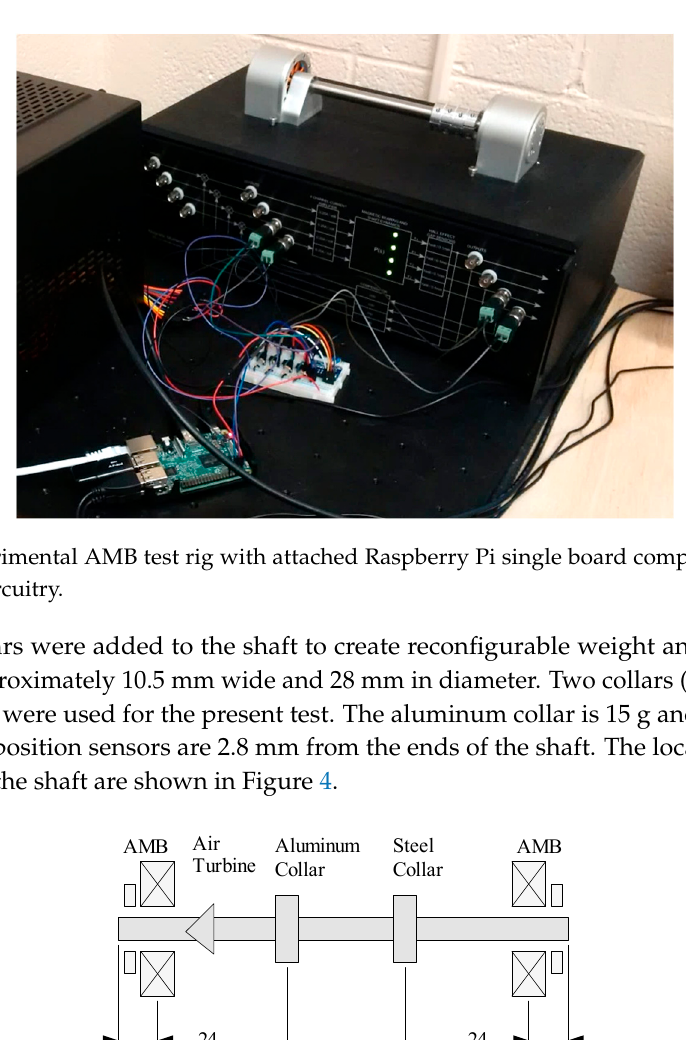
Figure 4. Rotor configuration. Dimensions in mm.